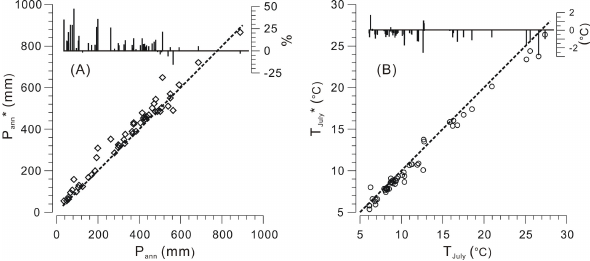
Fig. 4. Plot of inverse-distance-weighted climate parameters within individual pollen source area ( y axis) against climate data collected from the sampling point ( x axis): (A) mean annual precipitation; (B) mean July temperature. The vertical bar plot inserts indicate the dif- ferences in precipitation (percentages) and temperature